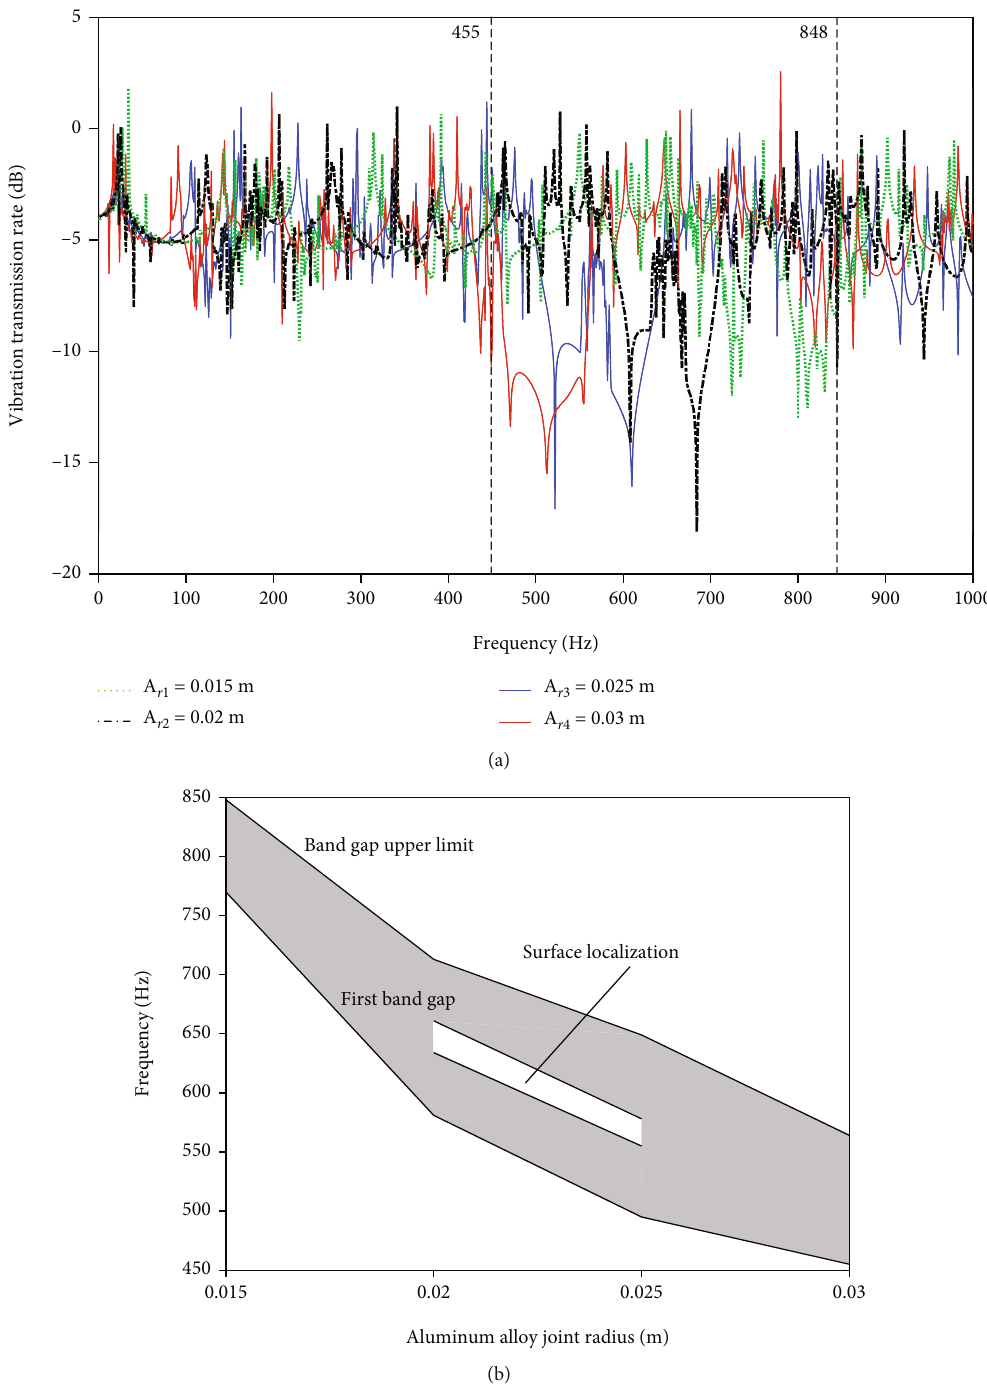
Figure 8: Corresponding to the change of the aluminum alloy section radius: (a) vibration transmission rate of node R ; (b) the fi rst band